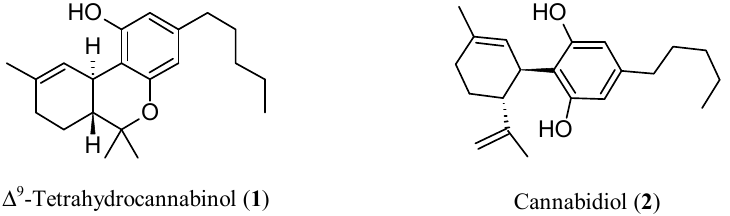
Figure 1. Chemical structures of Δ 9 -tetrahydrocannabinol (THC, 1 ) and cannabidiol (CBD, 2 ).